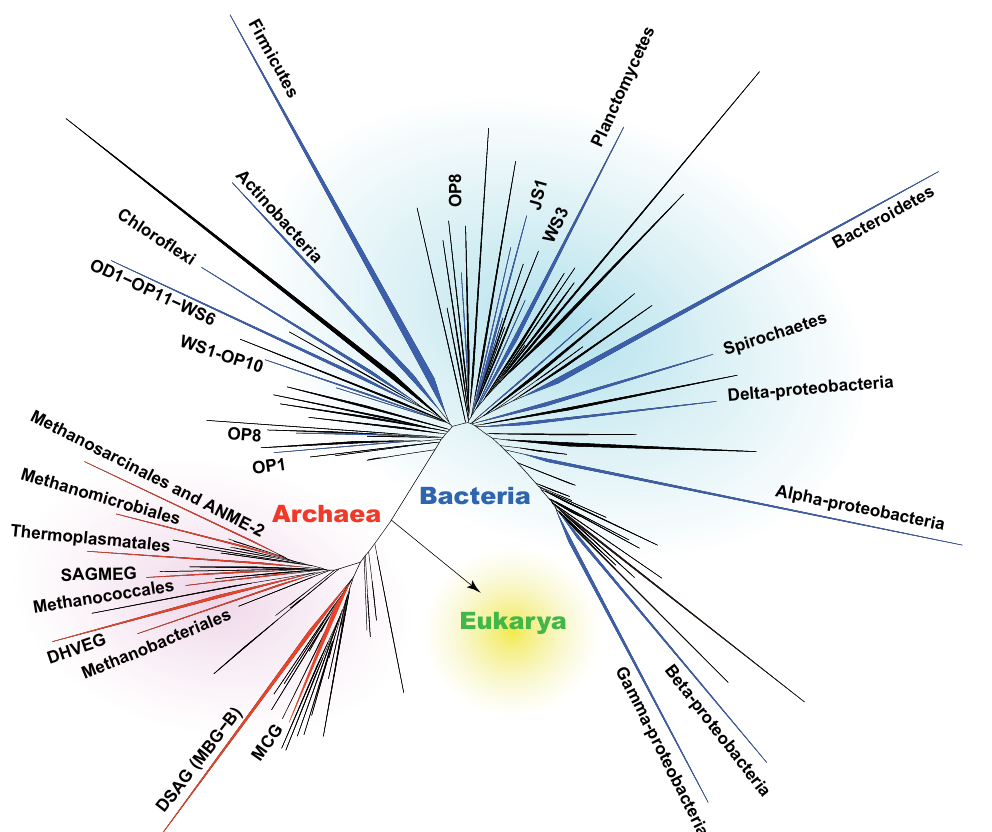
Figure 3.X. Phylogenetic tree of three domains of life on Earth (Archaea, Bacteria, and Eukarya). The tree is constructed by small subunit of ribosomal RNA genes including sequences detected from previous studies through the scientific ocean drilling (e.g., ODP Leg 201 and 204, IODP Exp. 301, 315 and 316: Inagaki, 2010). Branches marked in red and blue represent frequently detected phylogenetic groups in the domain Archaea and Bacteria, respectively. Most sequences from subseafloor sediments are distinct from cultured species, and hence physiology and functions of subseafloor life, as well as their distribution, adaptation, survival and evolutional contexts, remain largely to be demonstrated by challenges using new molecuar ecologial techniques through the future scientific ocean drilling oppotunities.